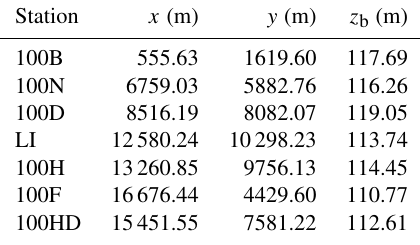
Table A1. Horizontal coordinates and bed elevation of survey locations.